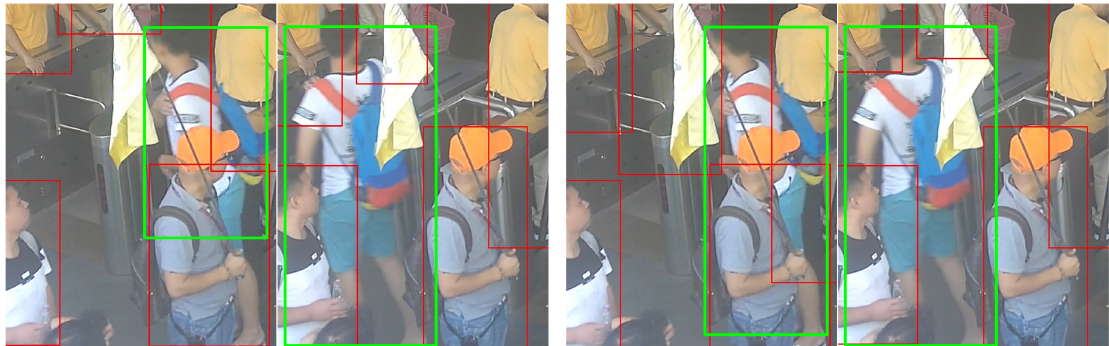
Figure 3. Detection result with soft-NMS (left) and NMS (right). The bounding box for the person in yellow is not miss deleted as redundant detection with soft-NMS.